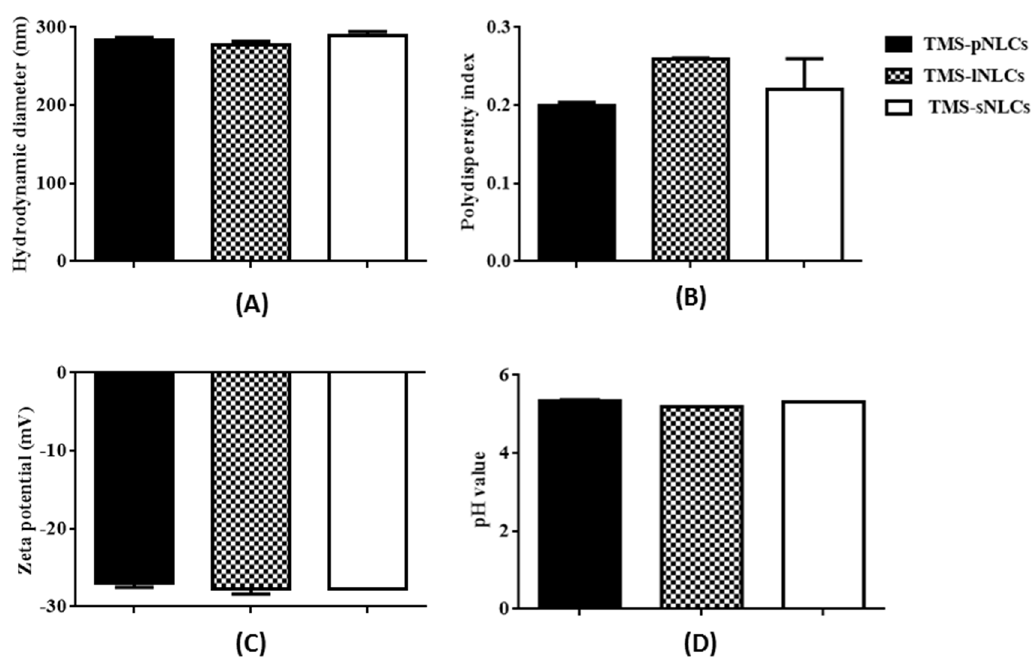
Figure 1. Hydrodynamic diameters ( A ), polydispersity index ( B ) and zeta potentials ( C ), and pH values ( D ) of tilmicosin-loaded nanostructured lipid carriers with palmitic acid (TMS-pNLCs), lauric acid (TMS-lNLCs), and stearic acid (TMS-sNLCs) in aqueous solution.